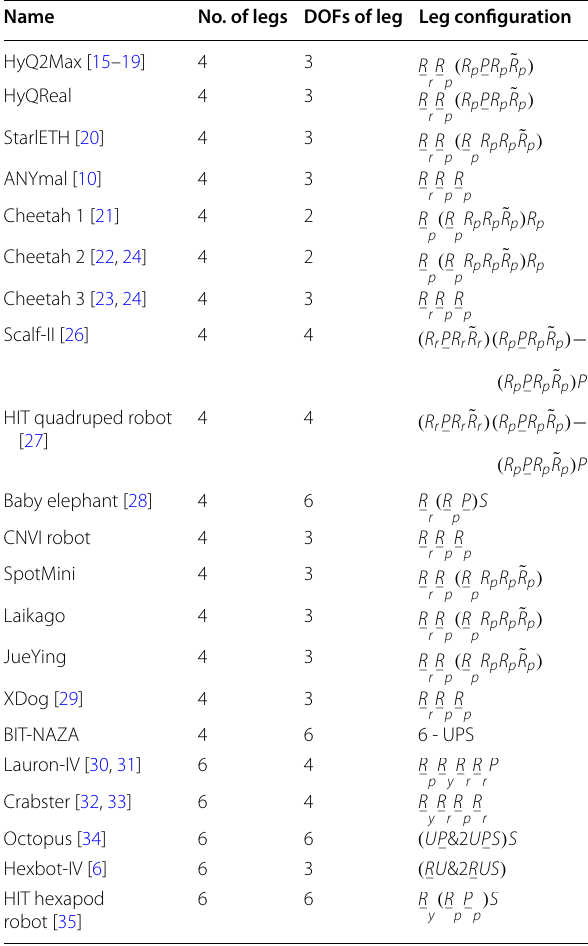
Table 5 Leg configurations of selected legged robots